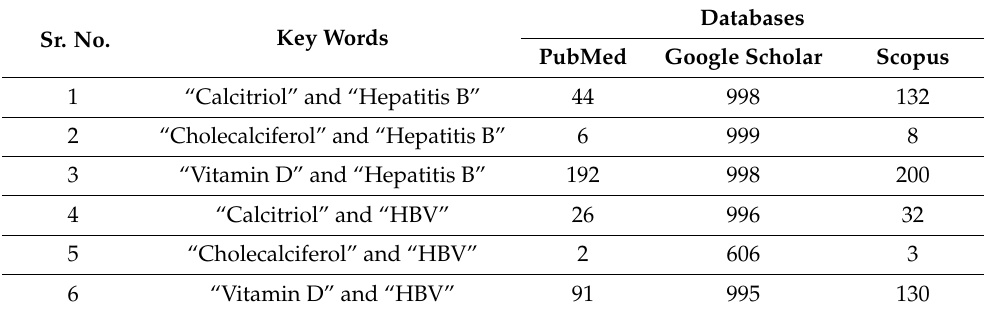
Table 1. Database search strategy and